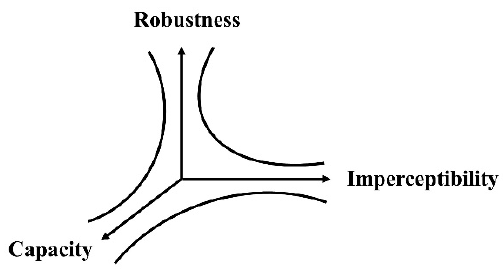
Figure 3. The trade-off among imperceptibility, robustness, and capacity. Table 1. Techniques that meet some requirements